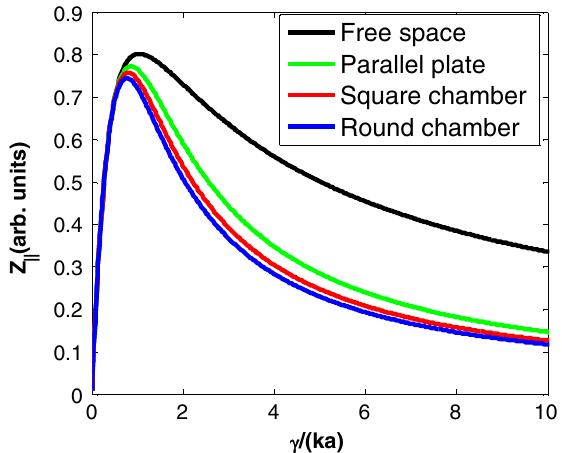
FIG. 12. Comparison of the shielding effect on the on-axis ¼ 2 a ), parallel plates impedance between a round chamber ( r FIG. 13. Comparison of the shielding effect between the round, w ¼ 4 a ) and a rectangular chamber ( h ¼ 2 r ( h ¼ 2 r square, and parallel-plate chambers on the average LSC imped- ) with the w w ance. The same beam and chamber parameters in Fig. 12 are used ratio w=h ¼ 1 , 2. The full height of the rectangular chamber h is here. The square chamber has an aspect ratio of w=h ¼ 1 . fixed and equal to the diameter of the round chamber.